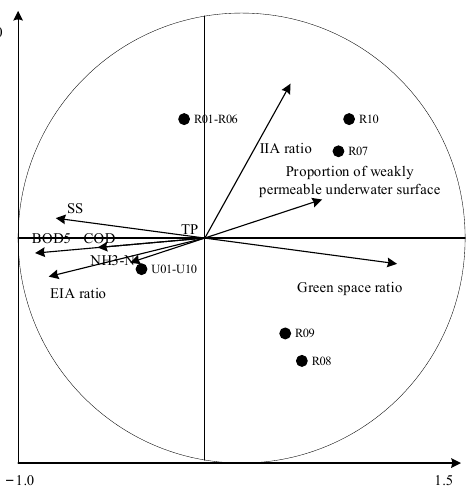
Figure 4. Redundancy analysis of land-use index and water quality indexes.